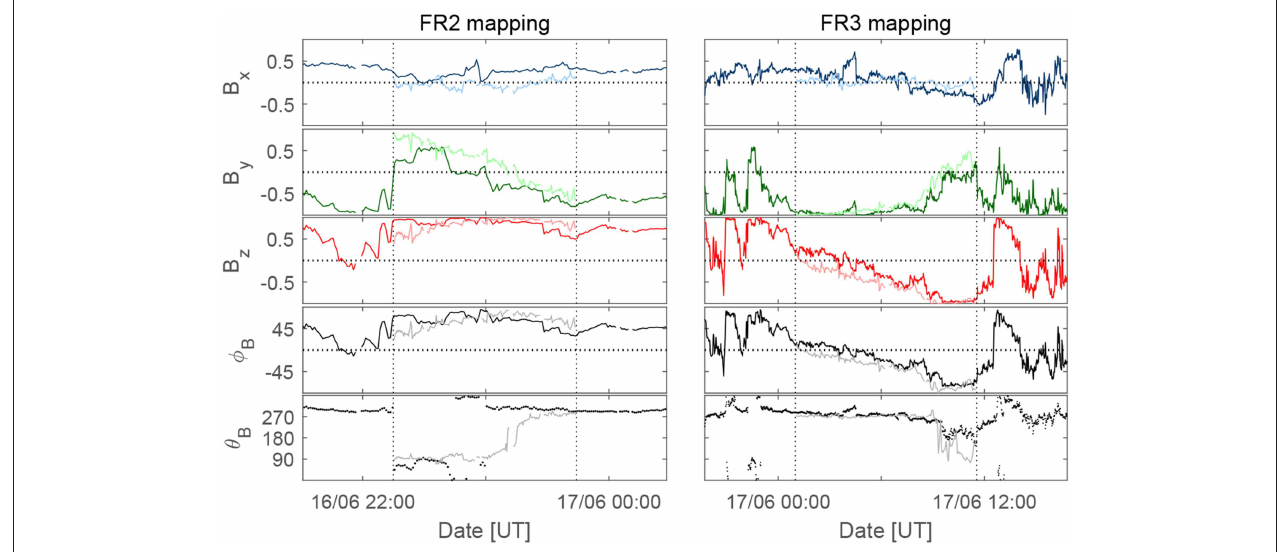
FIGURE 6 | Mapping of the magnetic field data between VEX (pale-colored lines) and Wind (dark-colored lines) for FR2 (Left) and FR3 (Right) . Details of the technique are given by Good et al. (2018). The panels show the normalized field components in the SCEQ coordinate system and the field latitude and longitude angles. Vertical dashed lines denote the flux rope